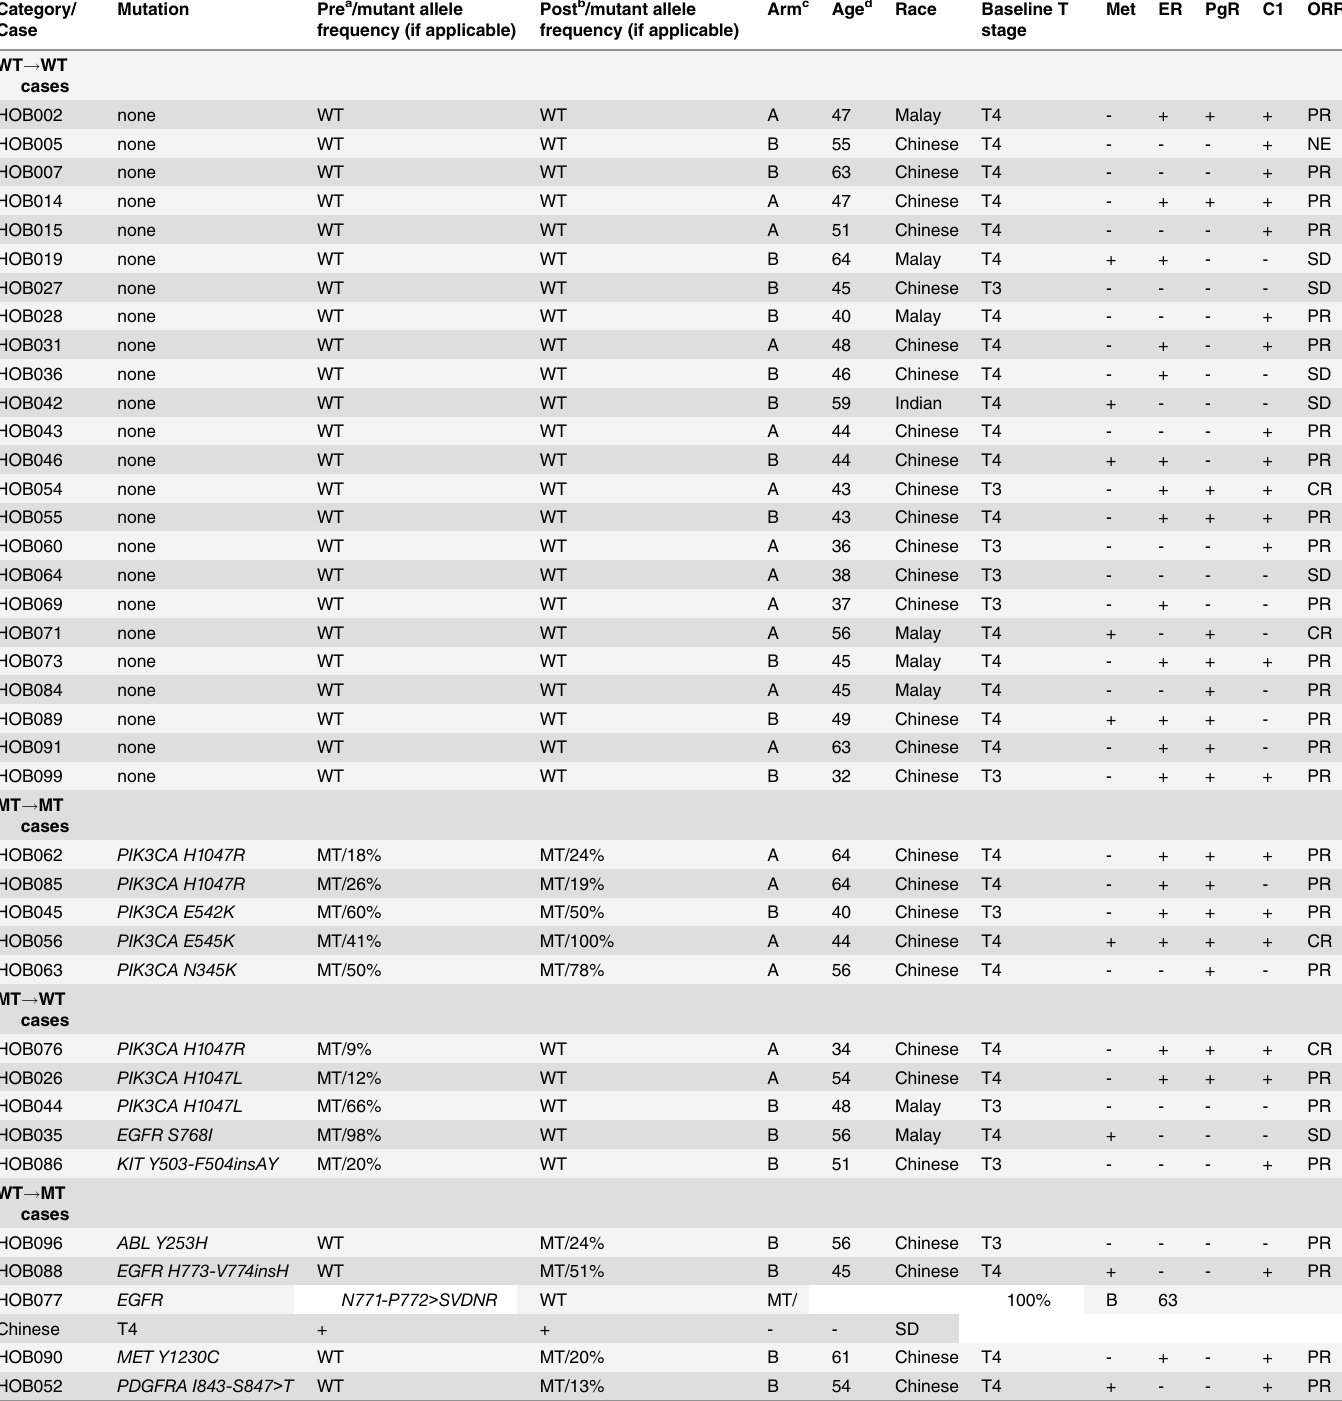
Table 1. Study cases according to mutation status in pre- and post-chemotherapy samples and their clinicopathological and tumor response characteristics (n = 40 pairs). Category/